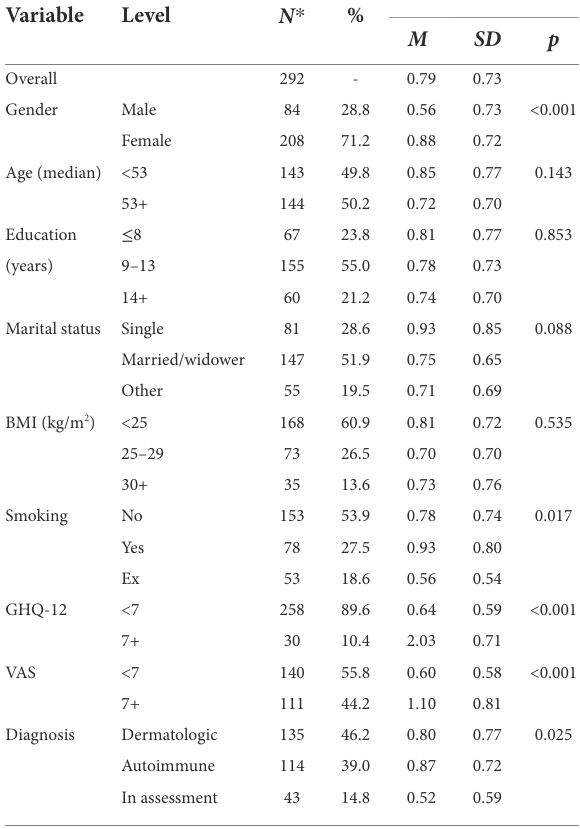
TABLE 1 Sociodemographic and clinical features of the study participants, with SCL-K-9 total mean